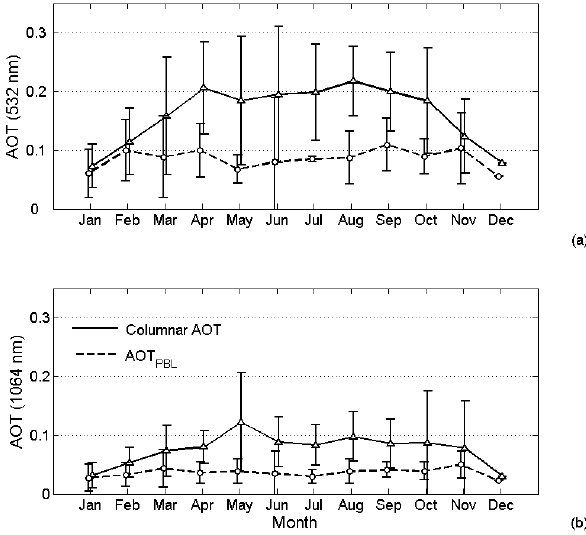
Fig. 3. Lidar-derived columnar AOT and fraction of the AOT included in the PBL.